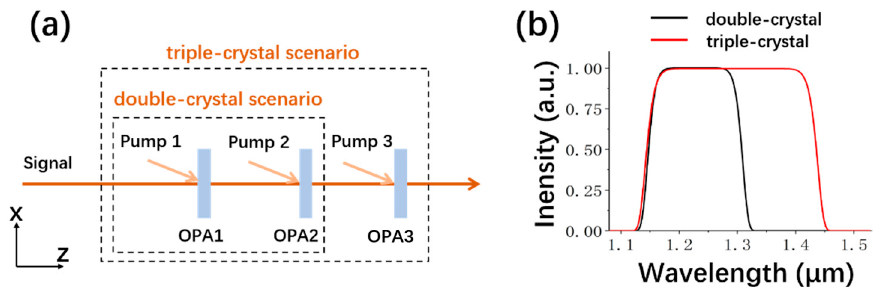
Figure 2. ( a ) The configurations of final amplifier of the OPCPA system for double-crystal scenario and triple-crystal scenario, ( b ) the super Gaussian signal spectrum of the two scenarios before amplification.